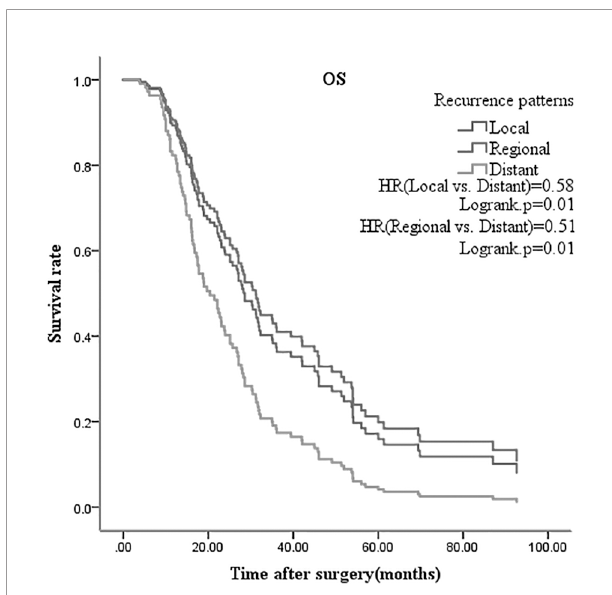
FIGURE 2 | Overall survival multivariate analysis of radical cholangiocarcinoma surgery according to recurrence